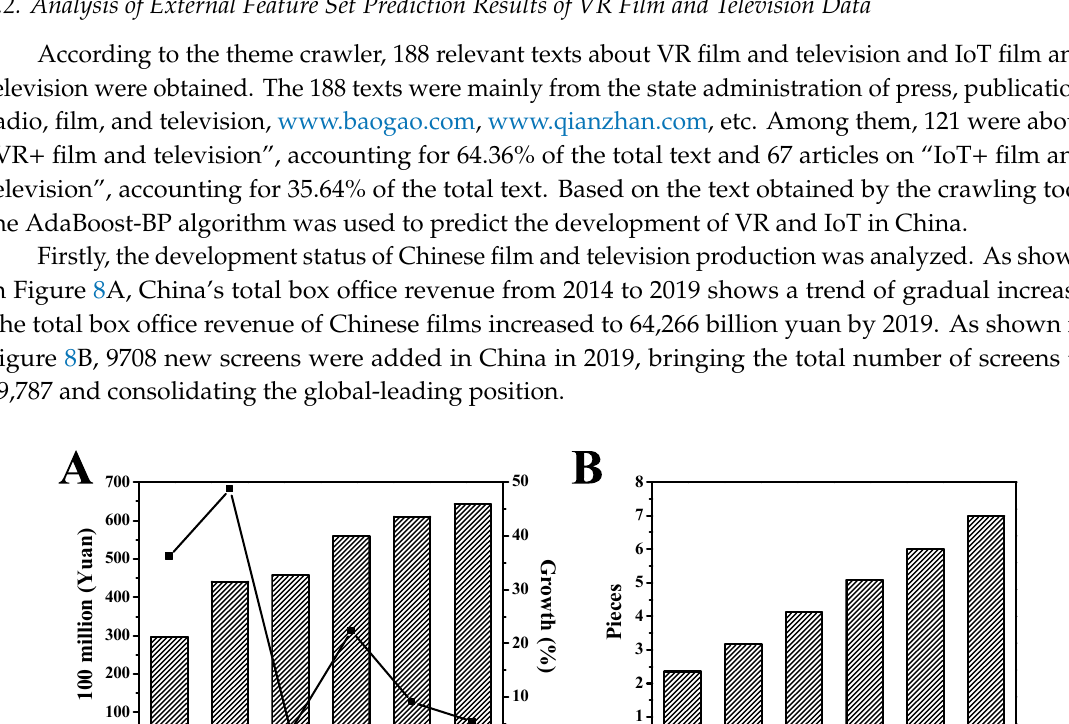
Figure 9. ( A-B ) Global VR headset shipments and market size changes. The actual and predicted volume of shipments and market size changes of the global VR industry in recent years were compared. It can be concluded from Figure 9 that both the shipment volume and the market size are increasing year by year. With the advent of the 5G era, the delay of VR products will be reduced by nearly 10 times, and the network efficiency will be improved by about 100 times, so the development of 5G will usher in an inflection point in the VR field. Based on the forecast results, it can be found from Figure 10A that VR headsets are expected to account for the largest proportion (37.8%) in China’s VR market segment by 2021. In addition, there are VR experience halls (6.6%) and VR cameras (2.2%). As shown in Figure 10B, VR games account for the largest proportion (34.0%), followed by VR film and television (32.0%), and VR live broadcasting (16.0%).